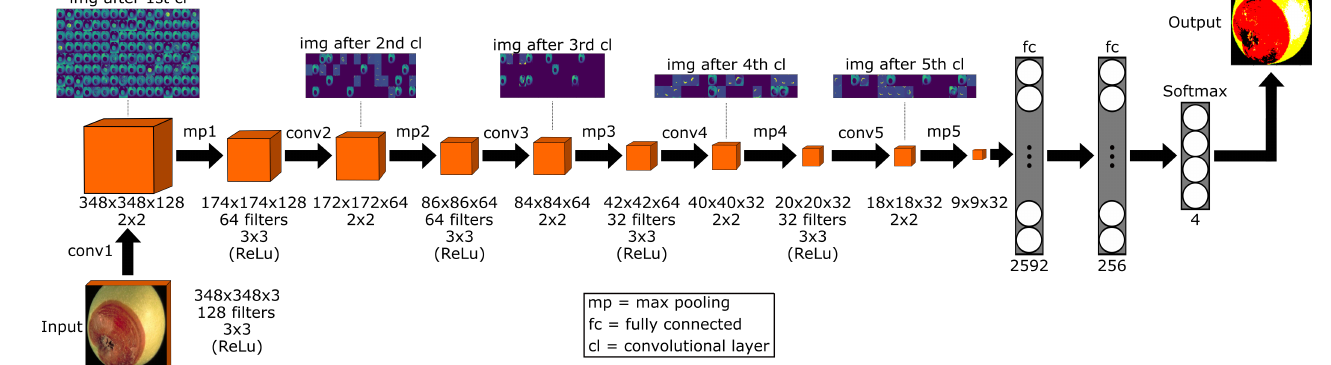
Figure 2. Deep Convolutional Neural Network (DCNN) structure for actual